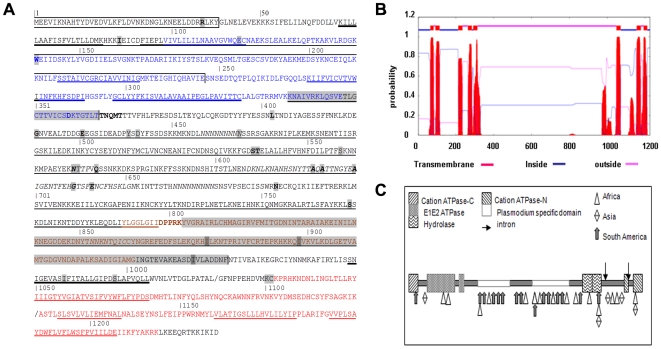
Predicted domains and localization of the mutations in Pf-SERCA protein sequence.A) Amino-Acid sequence of Pf-SERCA The functional domains of the protein are located according to the alignment with the rabbit ATPase: A (boxed), P (box-grey) and N (underlined), Plasmodium-specific domains are shown in italic. Hinge between P and N domains are bolded (TNQMT and DPPRK). Introns are located in the gene after L1019 and K1119 (noted by the sign/). Transmembrane domains are bold-underlined. Mutations are boxed in grey (non-synonymous mutation in bold). Three catalytic domains are predicted by PROSITE: cation atpase_N 3 – 81 and ATPase_C 1031–1215 (red), E1_E2 atpase 99 – 348/358-364 (blue), hydrolase 790–935 (braun). The position of the two introns is indicated with a/. B) Prediction of transmembrane domain by HMM (www.PROSITE.org) Ten transmembrane domains were predicted using TMpred with “in to out” (i-o) or “out to in”(o-i) orientation: M1 AA67-85 (o-i), M2 AA94-116 (i-o), M3 AA216-233 (o-i), M4 AA271-290 (i-o), M5 AA298-325 (o-i), M6 AA979-1005 (i-o), M7 AA1053-1073 (o-i), M8 AA1124-1140 (i-o), M9 AA1158-1175 (o-I), M10 AA1183-1206 (i-o). C) Schematic representation of the catalytic domains of Pf-SERCA and localization of the mutations. Mutations are given symbols by continent of origin of the isolates (non synonymous mutations depicted with filled arrows, synonymous mutations depicted with open arrows).